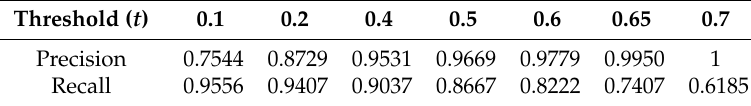
Table 4. The numerical values of precision and recall.